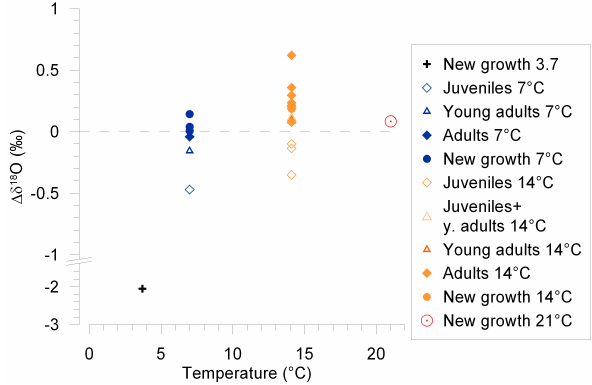
Fig. 6. The difference between δ 18 O c and the δ 18 O (eq) vs exper- imental temperature. δ 18 O (eq)) is indicated with a dotted line and calculated using the Bemis et al. (1998) paleotemperature equation, together with a δ 18 O w of 0.92 (average between FeB. and May). All calcite was precipitated during the experiment; the symbols refer to the different material, see legend for details.